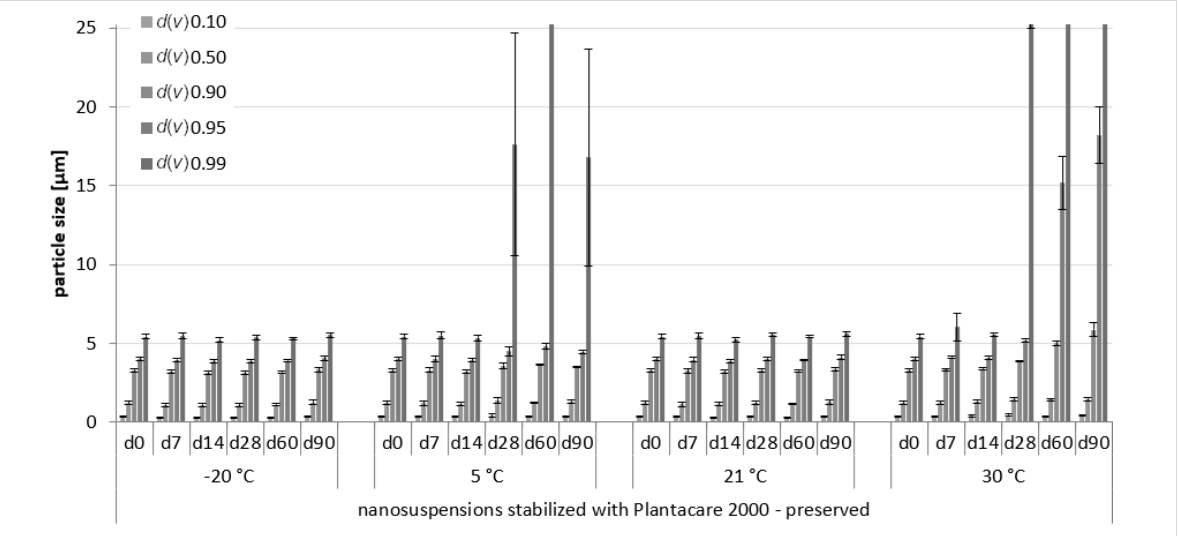
Figure 5: Physical stability during three months of storage at different storage temperatures for the preserved nanosuspensions stabilized with Plan- tacare 2000 (LD data).